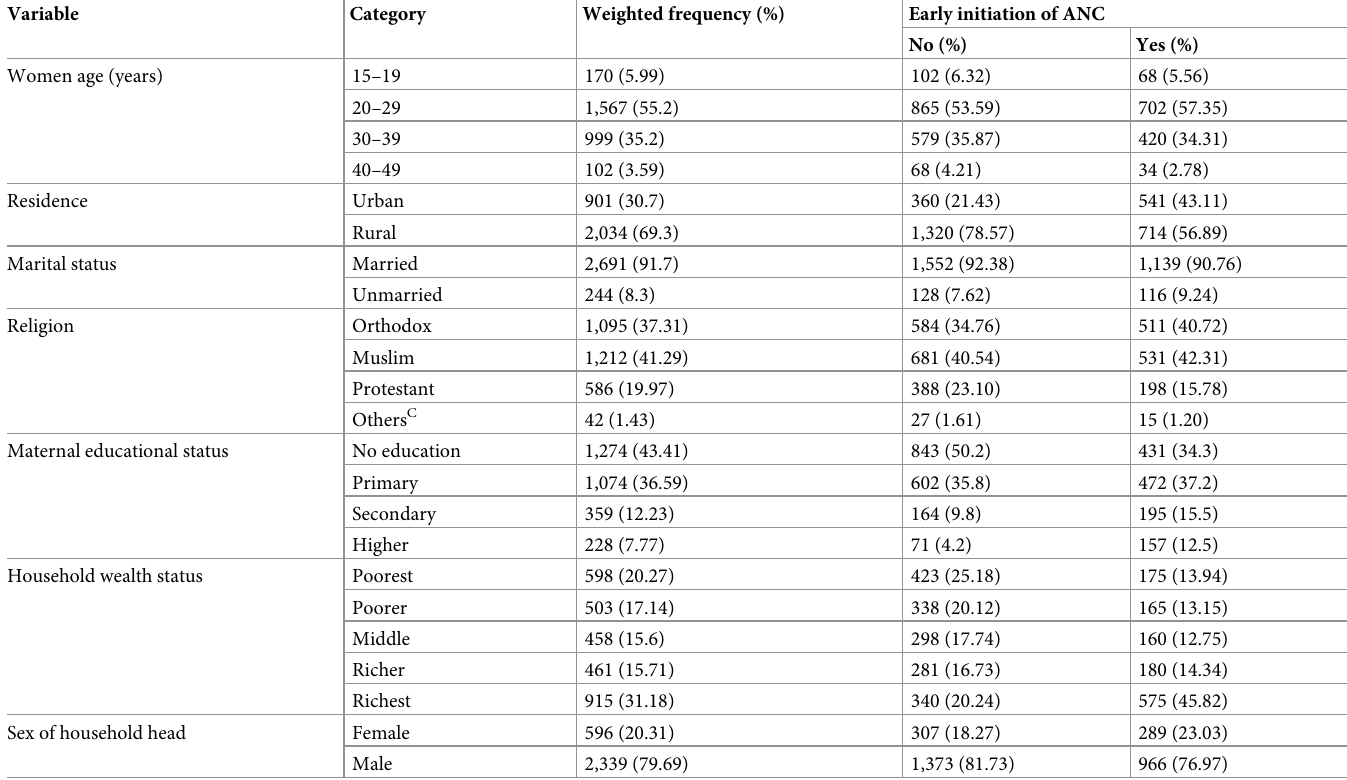
Table 2. Early initiation of first antenatal care visits by sociodemographic characteristics of reproductive-age women in Ethiopia, 2019.